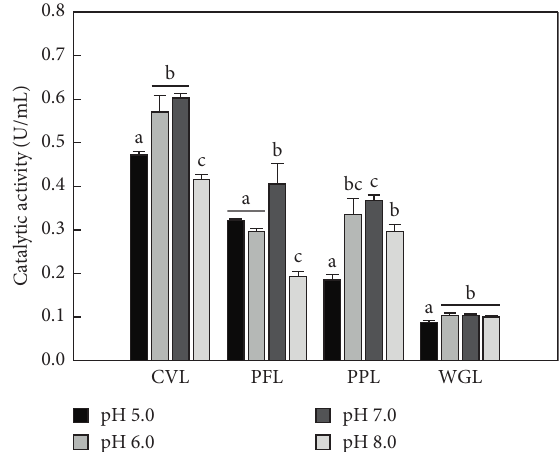
Figure 5: Effects of operating pH on the catalytic activity of lipases against 4-methylumbelliferyl oleate as a substrate. The operating pH was in the range of 5.0–8.0. Error bars indicate the standard error of the mean. Superscripts (a–c) above the bars denote sig- nificant differences in catalytic activity ( p < 0 . 05, Duncan’s multiple range test on ANOVA). CVL, Chromobacterium viscosum lipase (0.1 μ g/mL); PFL, Pseudomonas fluorescens lipase (0.1 μ g/mL); PPL, porcine ( Sus scrofa ) pancreatic lipase (10mg/mL); WGL, wheat germ ( Triticum aestivum ) lipase